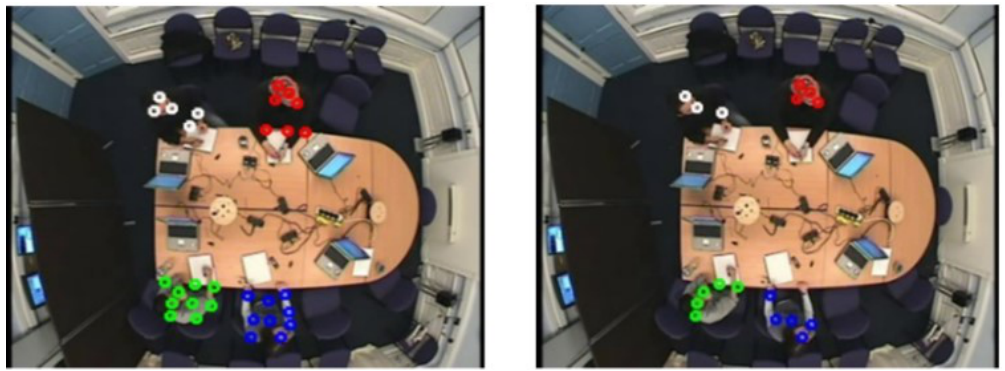
Figure 3. Sample images to show corner detection; left : without a corner scoring function; right : with a corner scoring